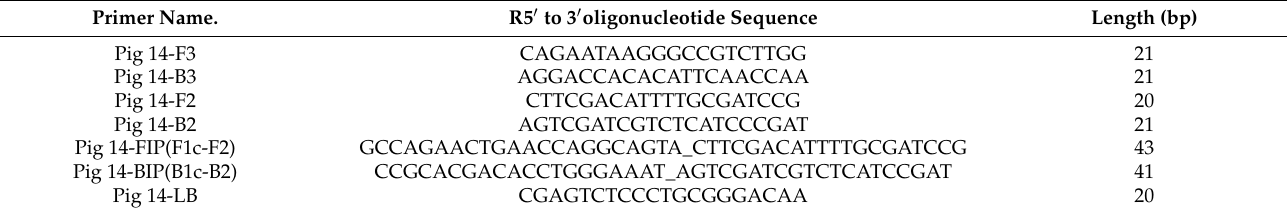
Table 1. Primer sequences used for LAMP assay in the detection of Pyrenophora graminea . Primer Name.